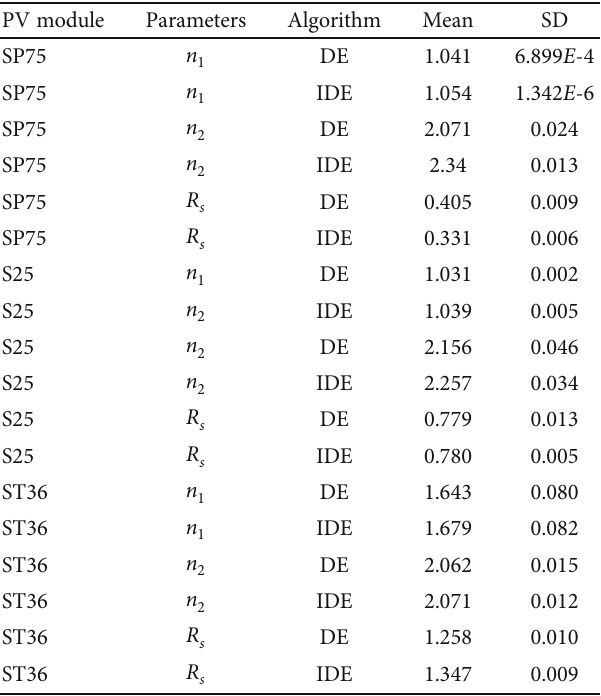
Table 2: The statistical results for RTC France PV cell and Photowatt-PWP 201 PV module.